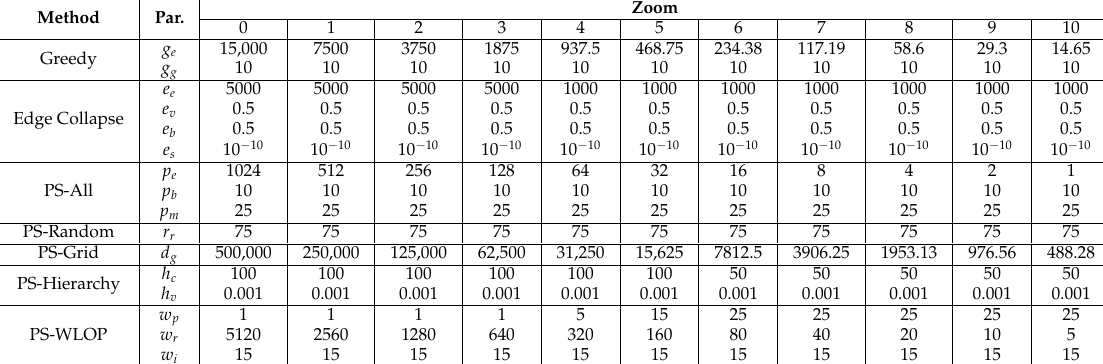
Table 3. The parameters used to generate the results in Section 5.2, specified for each zoom in the